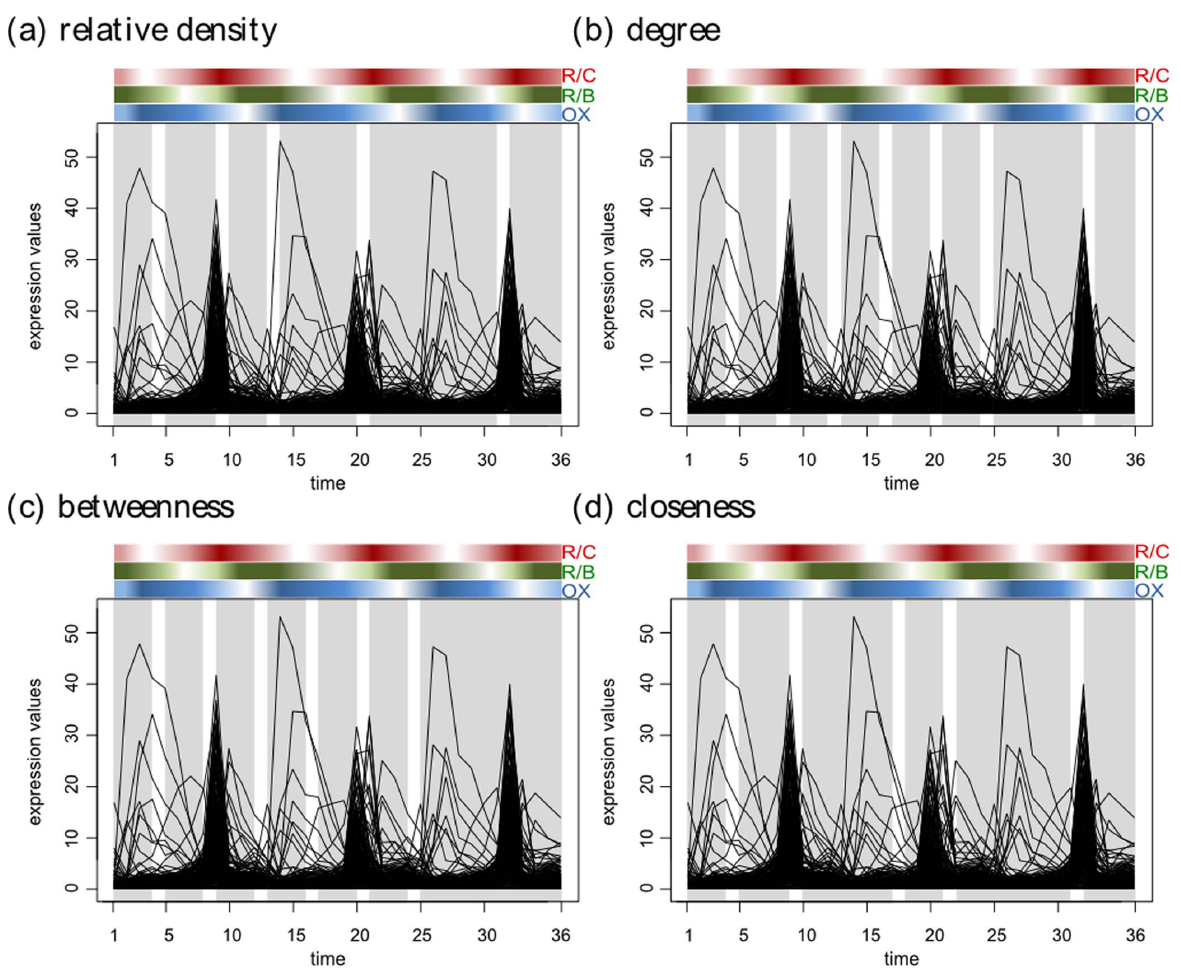
Figure 5. Segmentation for yeast’s metabolic cycle. The partitions found by applying our method are highlighted in light grey. The phases of the yeast metabolic cycle are indicated with colored rectangles above each panel following Tu et al. [36]. R/C stands for reductive charging, OX oxidative metabolism, and R/B, reductive metabolism. (a) shows the segmentations caught by relative density as global property; (b) illustrates the segmentations based on degree; (c) and (d) demonstrate segmentations with local-global properties, betweenness and closeness, respectively. The segmentations in panel (a) performs particularly well due to the global changes in the form of global cycles in the data set from yeast.